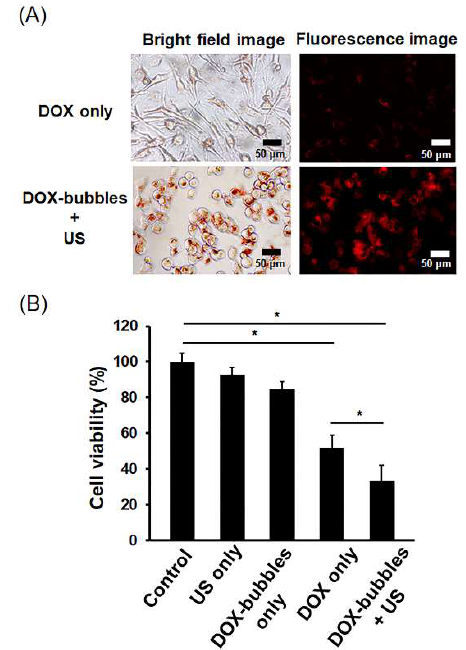
Figure 5. In vitro antitumor effect of DOX-bubbles and US (ultrasound) sonication. ( A ) Bright-field and fluorescent images of MG-63 cells treated with DOX, and DOX-bubbles + US. ( B ) Cell viability after treatment. Single asterisk, p < 0.05.